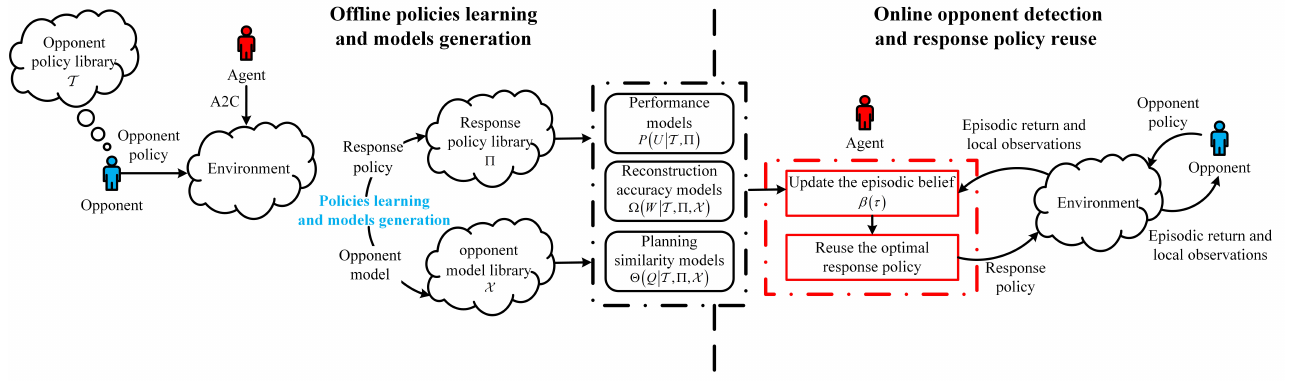
Figure 1. An overview of